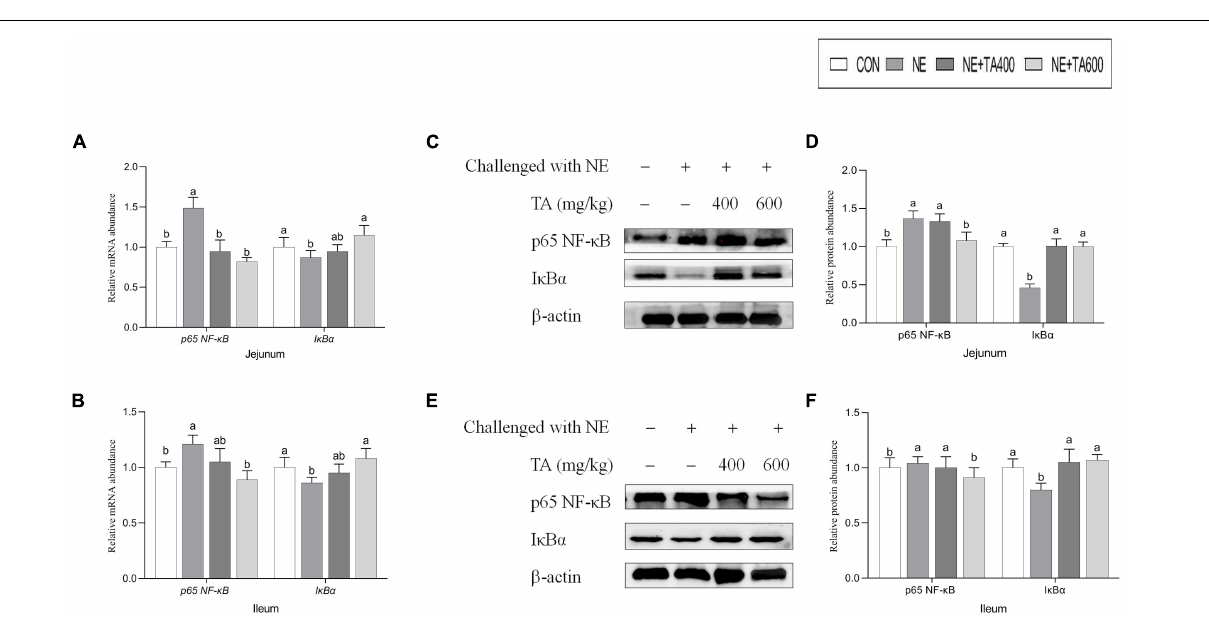
FIGURE 6 | The effects of TA on the intestinal NF- κ B signaling pathway of subclinical NE broilers. (A,B) Jejunal and ileal mRNA abundance of p65 NF- κ B and I κ B α , (C,D) jejunal nuclear translocation level of p65 NF- κ B and cytoplasmic level of I κ B α , (E,F) ileal nuclear translocation level of p65 NF- κ B and cytoplasmic level of I κ B α . Values were expressed as mean with standard error represented by vertical bars. a , b Means with different letters differ significantly among the groups ( P < 0.05). NF- κ B, nuclear factor kappa beta; I κ B α , NF-kappa-B inhibitor